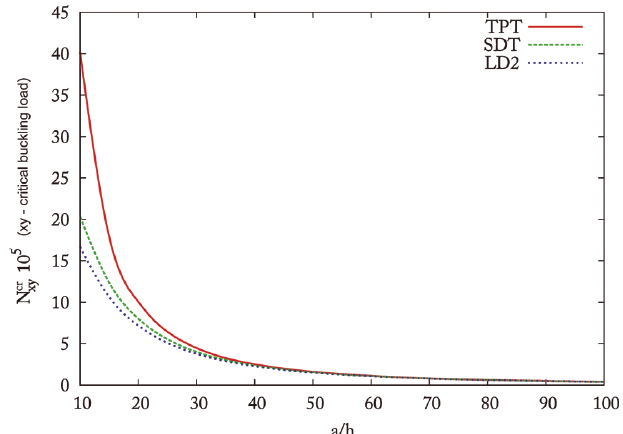
Fig. 4. PS on a SSSS plate. PLATE-31, Q4, 10 × 10, a =